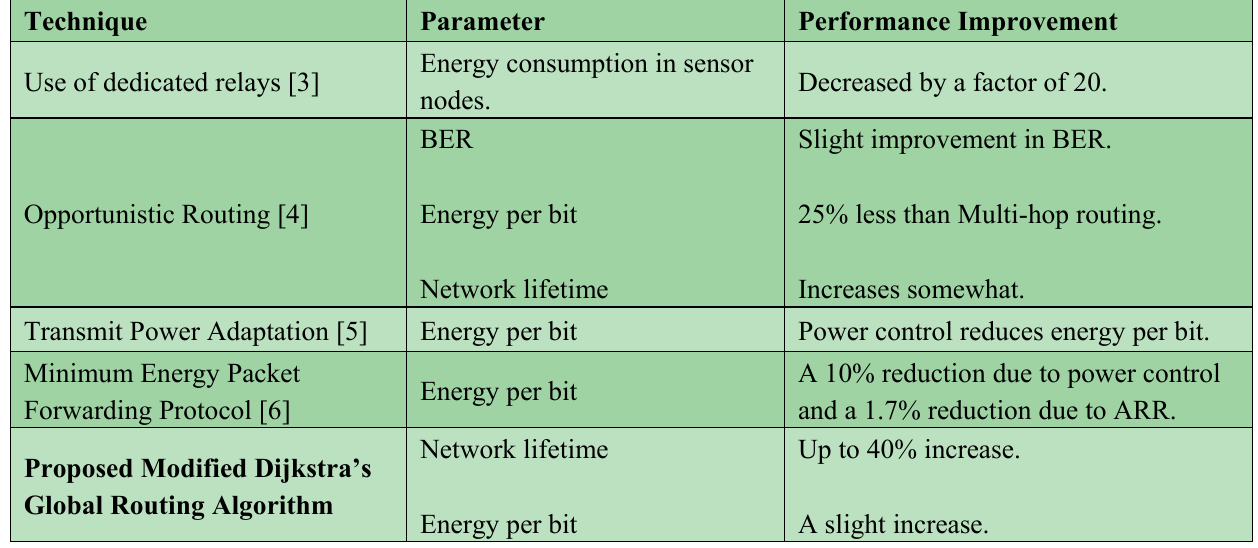
Table 2. Summary of WBAN routing algorithms